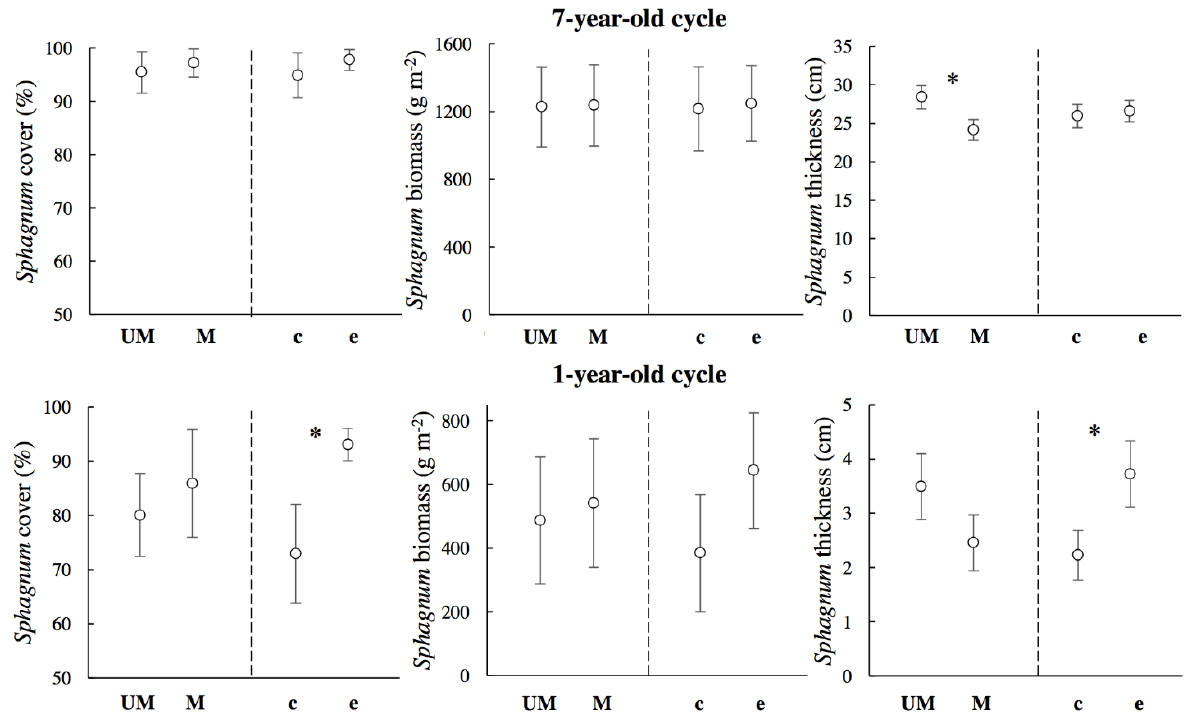
Figure 2. Means ± CI (95 %) for Sphagnum moss cover, moss layer thickness and biomass according to mowing treatment (UM = un-mown or M = mown) and transect position (c = centre or e = edge) for both production cycles (simple effects). An asterisk (*) indicates a significant difference between treatments (p - value < 0.05) (LSD protected, α = 0.05). There was no significant interaction between factors (mowing and transect position). Production cycles were analysed